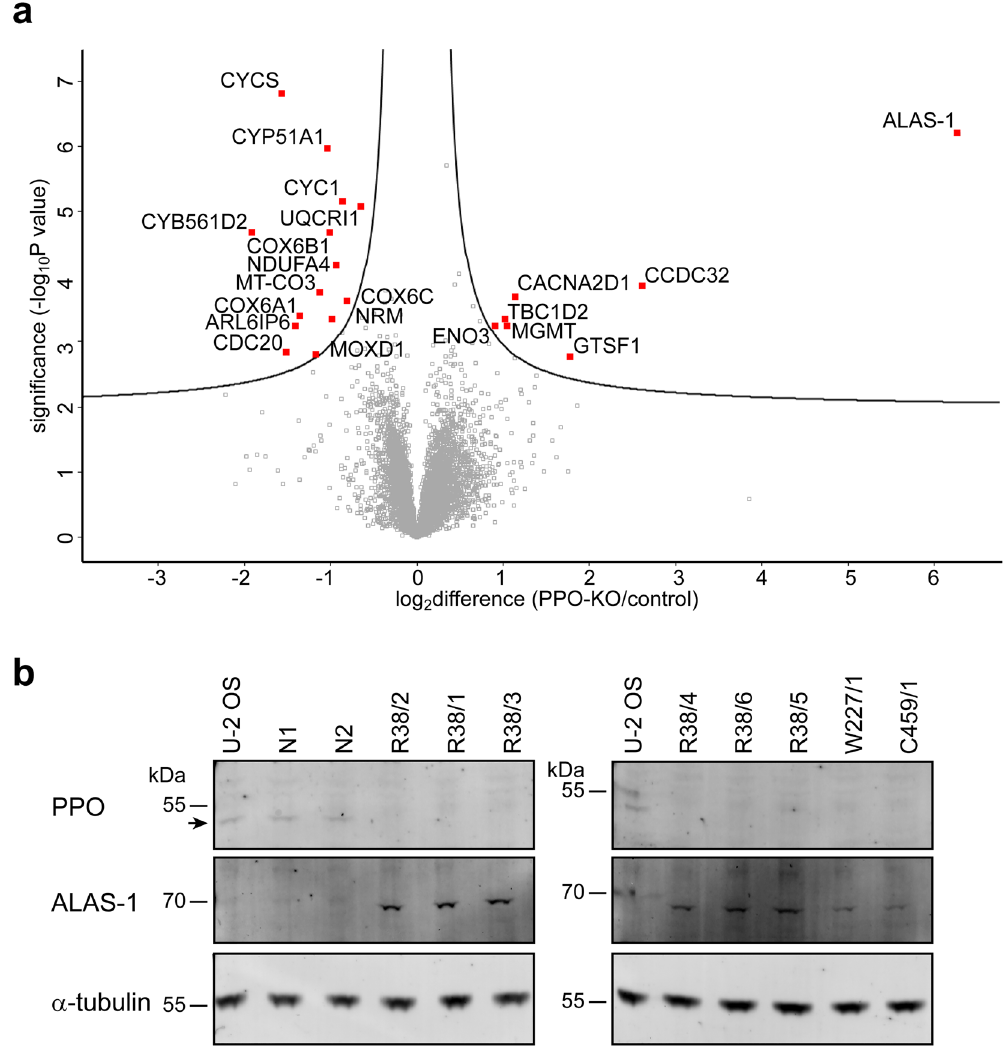
Figure 3. Analysis of protein levels in PPO-KO cells. ( a ) Volcano plot of significantly differentially abundant proteins in PPO-KO cells compared to control cell lines. Cell lysates of two control (U-2 OS and N2) and two PPO-KO (R38/1 and W227/1) clones were digested with Lys-C/trypsin and resulting peptides identified and quantified using mass spectrometry-label free quantification analysis. In the volcano plot, the − log 10 (Benjamini–Hochberg corrected P value) is plotted against the log 2 (fold change: PPO-KO/control). Proteins significantly dysregulated in PPO-KO clones (localized above the curves drawn in Perseus with parameters FDR 0.05, s0 0.1.) are marked in red. ( b ) Expression levels of PPO (position marked by arrow) and ALAS-1 were determined by Western blotting of cell lysates separated by SDS-PAGE. Alpha-tubulin was used as a loading